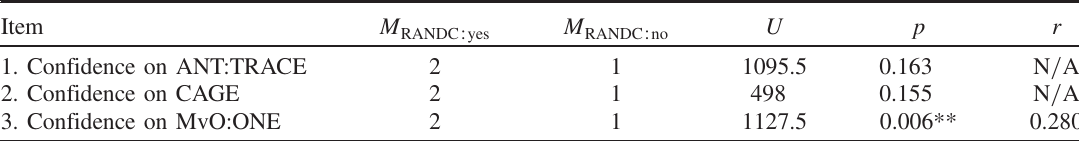
TABLE VIII. Results of the two-group Mann-Whitney U test and median values for each group of students who indicated awareness of radioactive decay as a random occurrence on a given